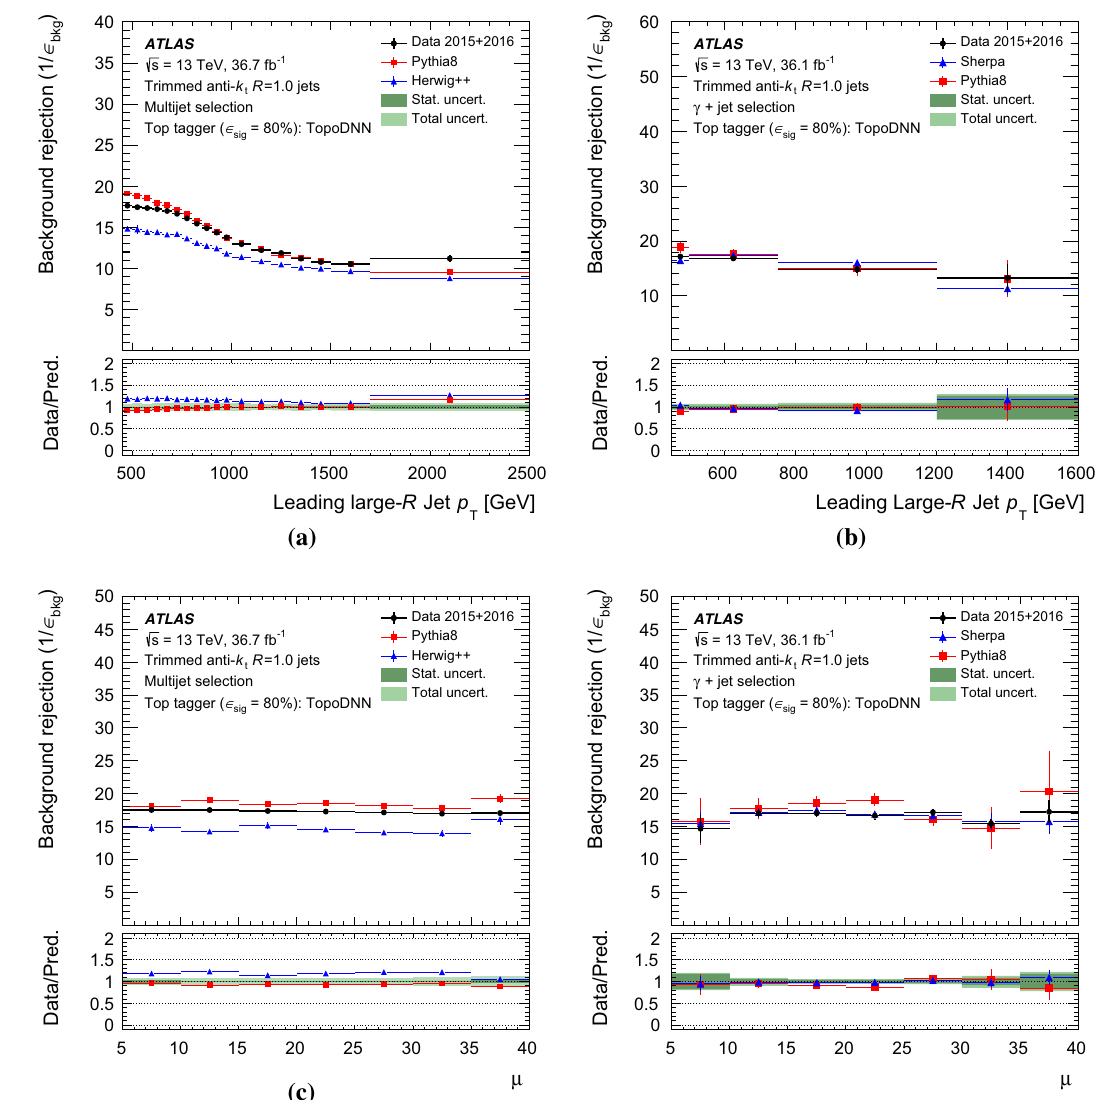
Fig. 37 The estimated light-jet rejection 1 /(cid:12) bkg as a function of the leading jet p T and the average number of interactions per bunch crossing μ for the TopoDNN top-quark tagger in the multijet ( a , c ) and γ + jet ( b , d ) selection